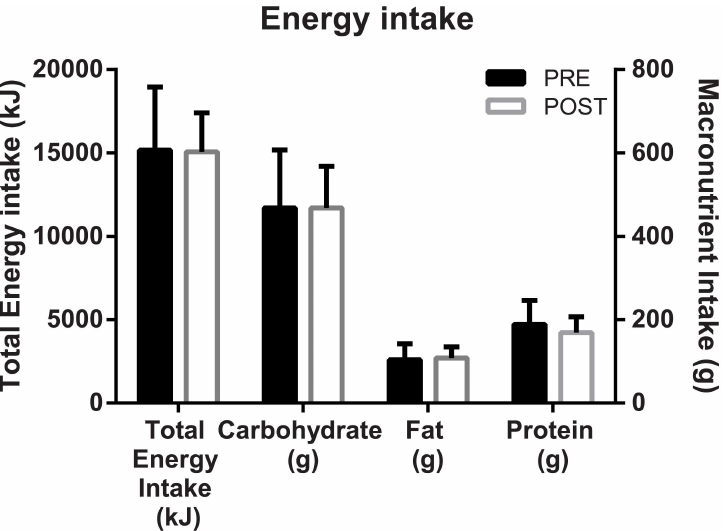
Fig 2. Energy and macronutrient intake PRE and POST the four-week training cycle. Data are presented as mean ± SD for each parameter PRE and POST. Where a significantdifference betweentime points is observed, * indicatesp < 0.05.